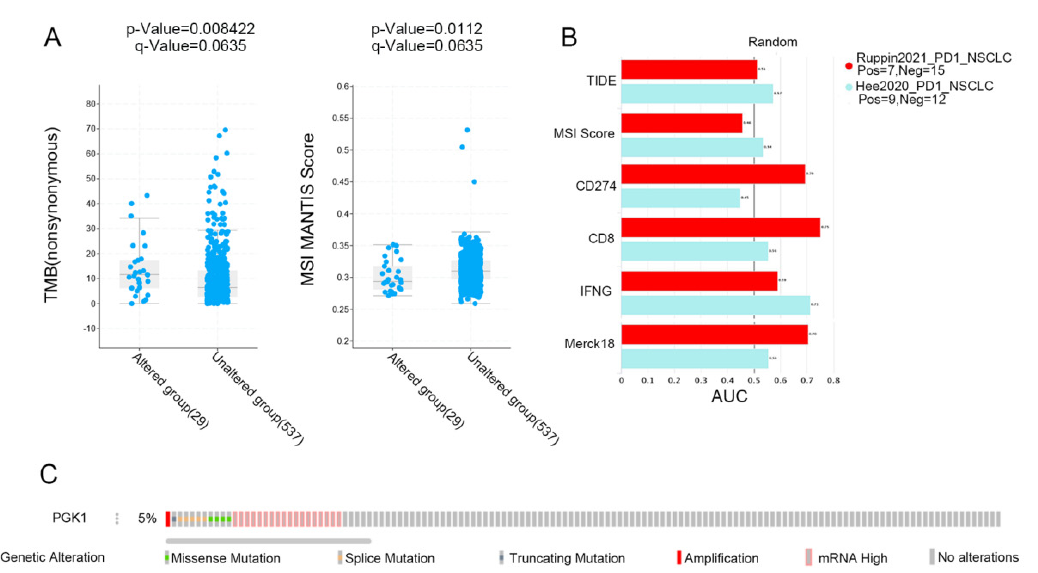
Figure 9. Immunopredictive score of PGK1 in LUAD. ( A ) PGK1 expression related to TMB and MSI in LUAD. ( B ) Common immunopredictive scores of PGK1 in NSCLC including TIDE (Tumor Immune Dysfunction and Exclusion). ( C ) Data of PGK1 altered in LUAD were obtained from the cBioportal database.